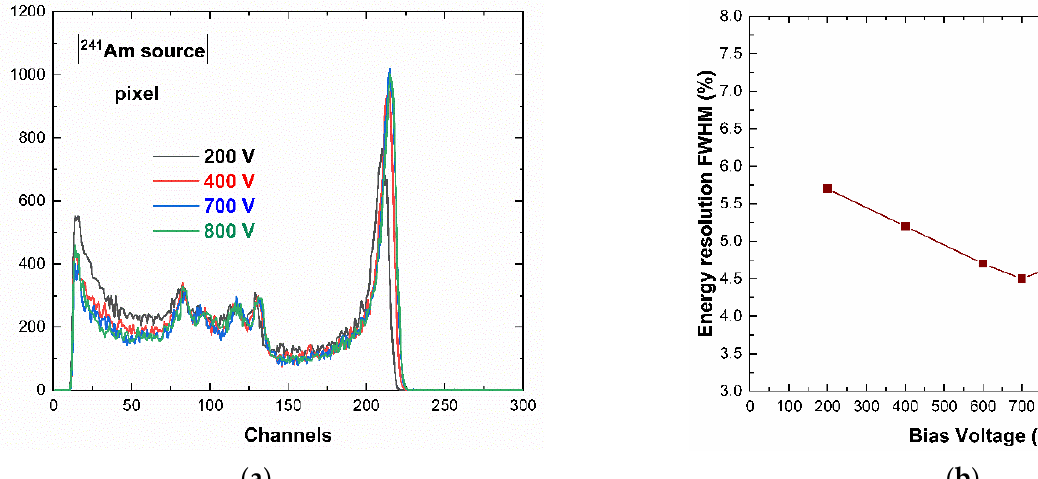
cathode bias voltages (negative bias voltage). The best energy resolution, equal to 4.5% (2.7 keV) FWHM at 59.5 keV, was obtained at −700 V. (2.7 keV) FWHM at 59.5 keV, was obtained at − 700 V.